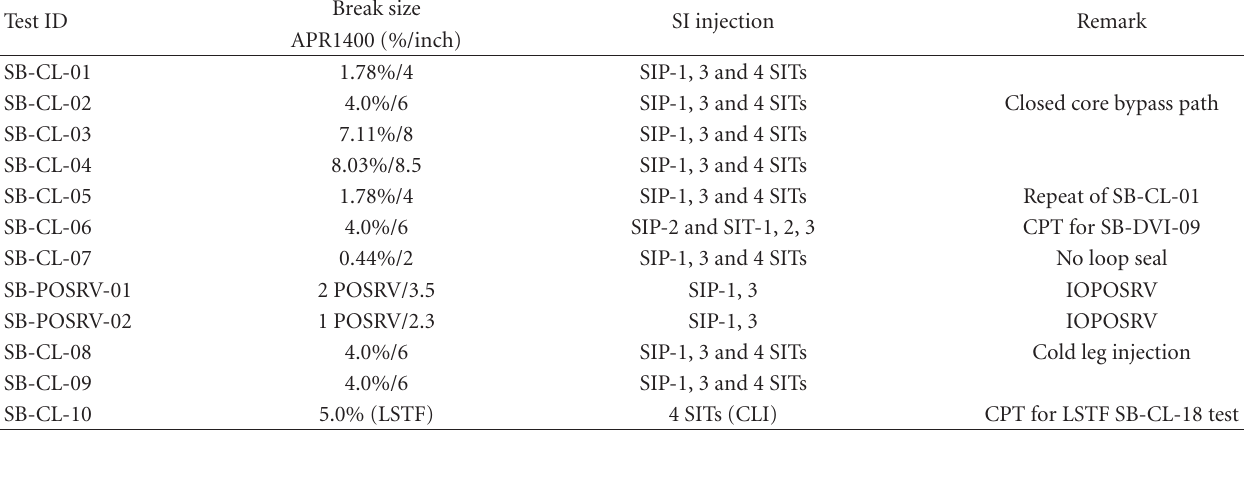
Table 4: Test matrix for the cold leg SBLOCA tests.